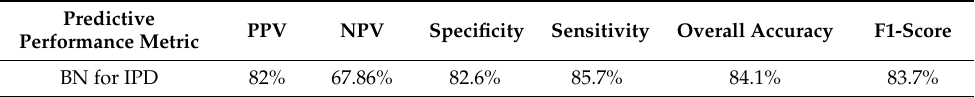
Table 6. Summary of the predictive performance results of the BN model developed to model IPD as Illustrated in Figure